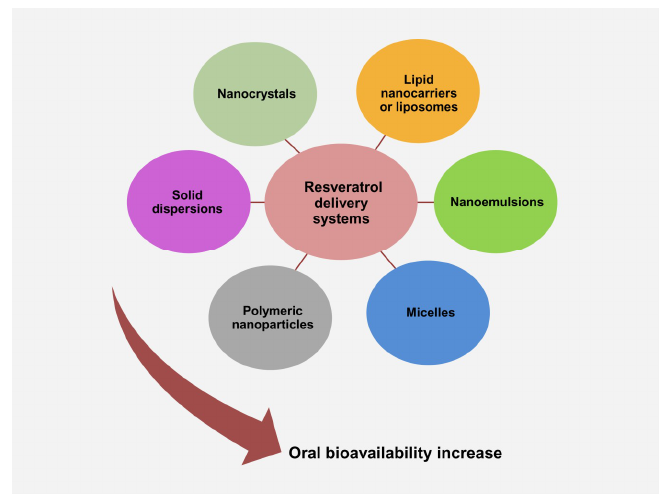
Figure 2. Principal resveratrol delivery systems to enhance its oral bioavailability.